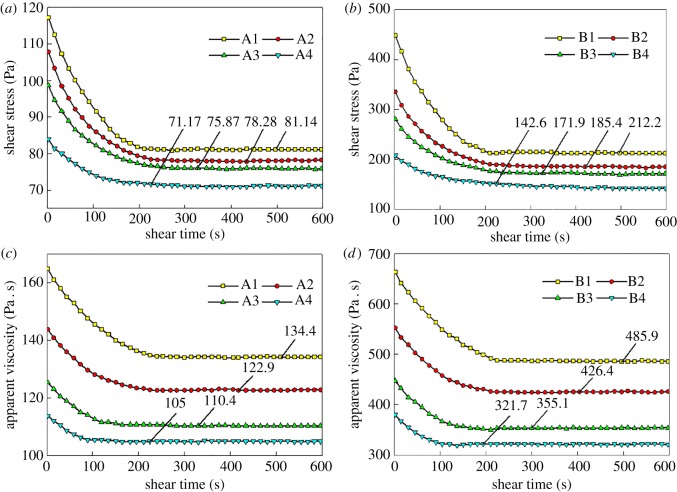
Flowability of the filling slurry: (a,b) are the shear stress for Groups (A) and (B) and (c,d) are the apparent viscosities for Groups (A) and (B).